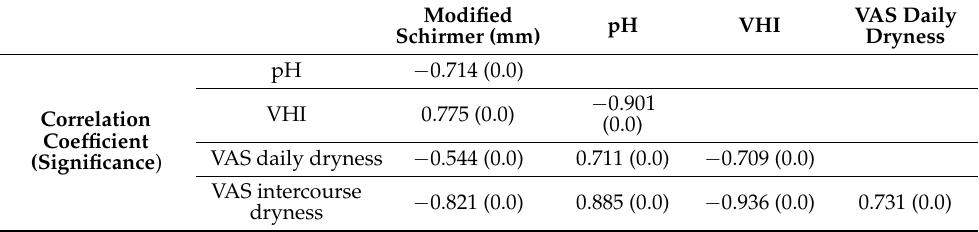
Table 4. Correlations between the different measures. Pearson’s correlation coefficient is a measure of the linear correlation between these parameters. Correlation coefficients of 1 or − 1 represent perfect correlations, whereas a correlation coefficient of 0 represents no correlation. Thus, the closer to 1 or − 1 the value of the coefficient is, the stronger the